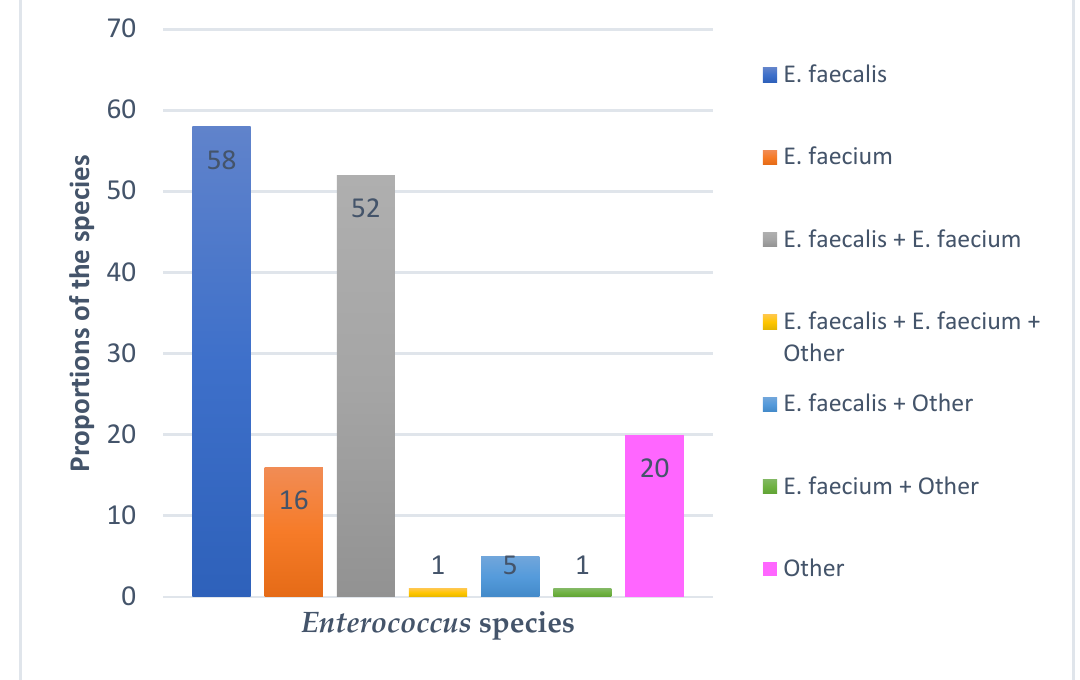
Figure 1. Enterococcus species identified using species-specific E. faecalis and E. faecium primers .